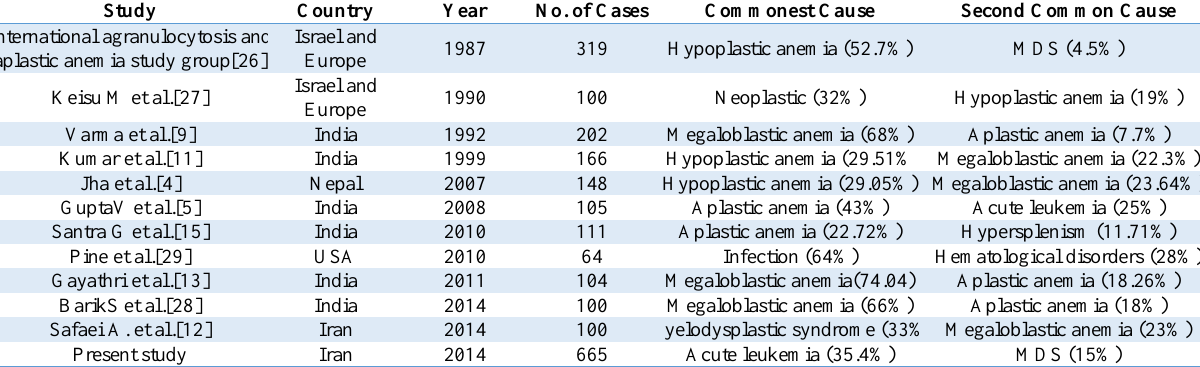
Table 4. Comparative Studies on